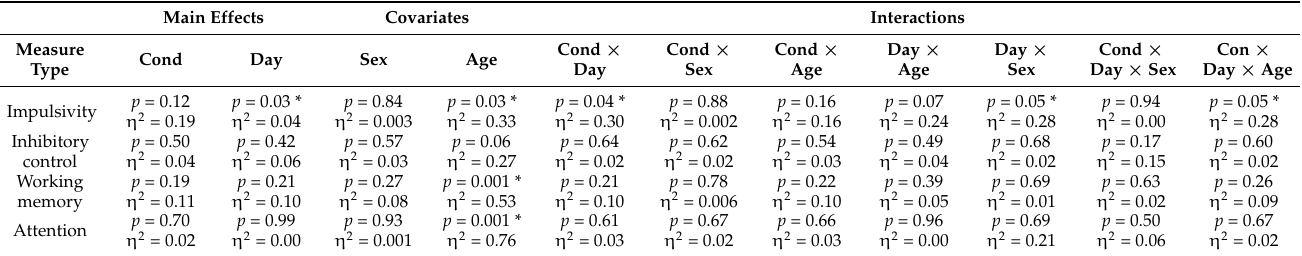
Table 4. Repeated measures ANOVA: diet vs. learning task.